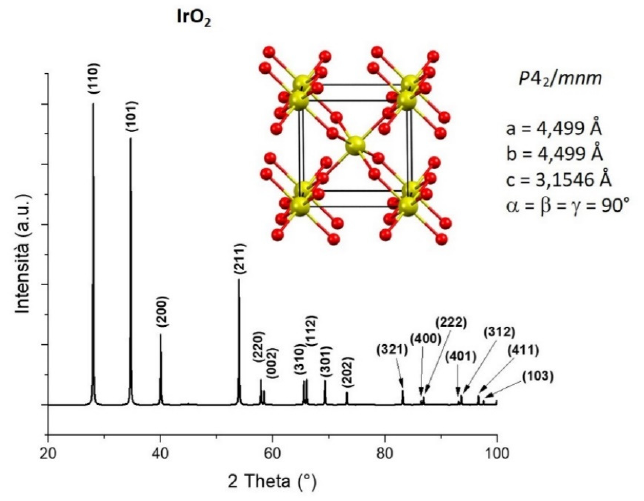
Figure 1. Unit cell, cell parameters and X-ray diffraction pattern with relative (hkl) indexation of IrO 2 , information extracted from deposited crystal structure (yellow: Ir atoms, red: O atoms) [2]. Unlike other transition metal oxides, IrO 2 shows a metallic-type conductivity (~10 4